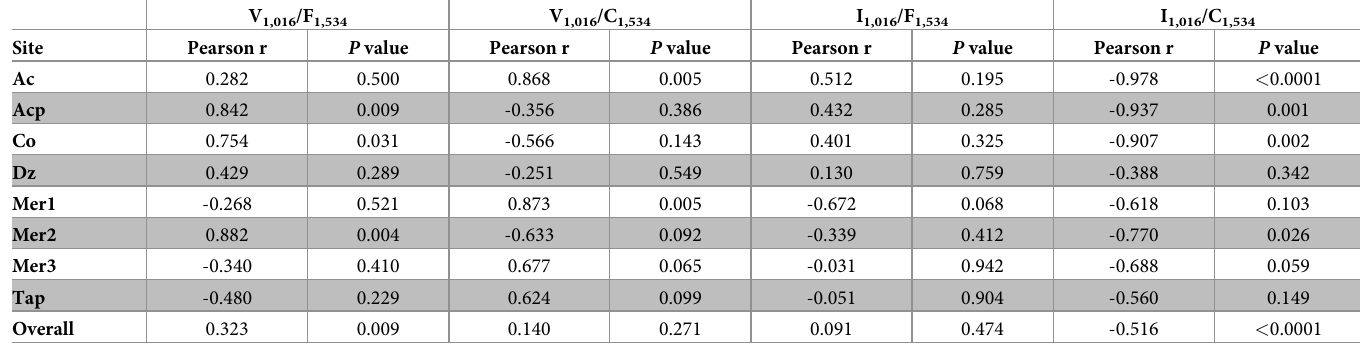
Table 5. Pearson’s correlation coefficient and p value for four possible haplotypes at loci V1,016I and F1,534C. Haplotypes: both susceptible alleles in cis = V 1,016 / F 1,534 , susceptible V 1,016 and resistant C 1,534 alleles in cis = V 1,016 /C 1,534 , resistant I 1,016 and susceptible F 1,534 alleles in cis = I 1,016 /F 1,534 , and resistant I 1,016 and resistant C 1,534 alleles in cis = I 1,016 /C 1,534